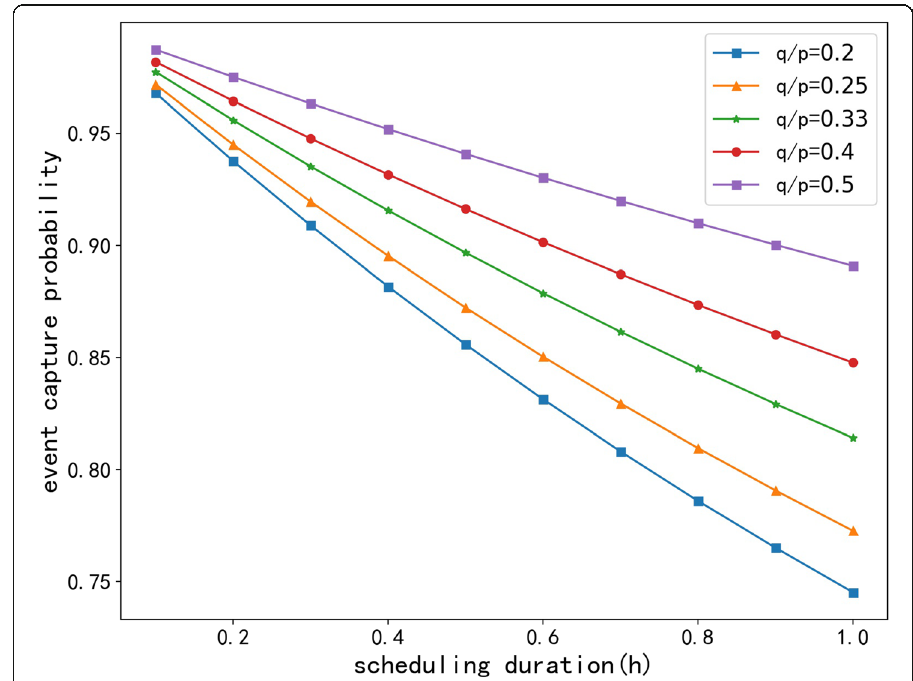
Fig. 1 Effect of scheduling duration on event capture probability in different duty